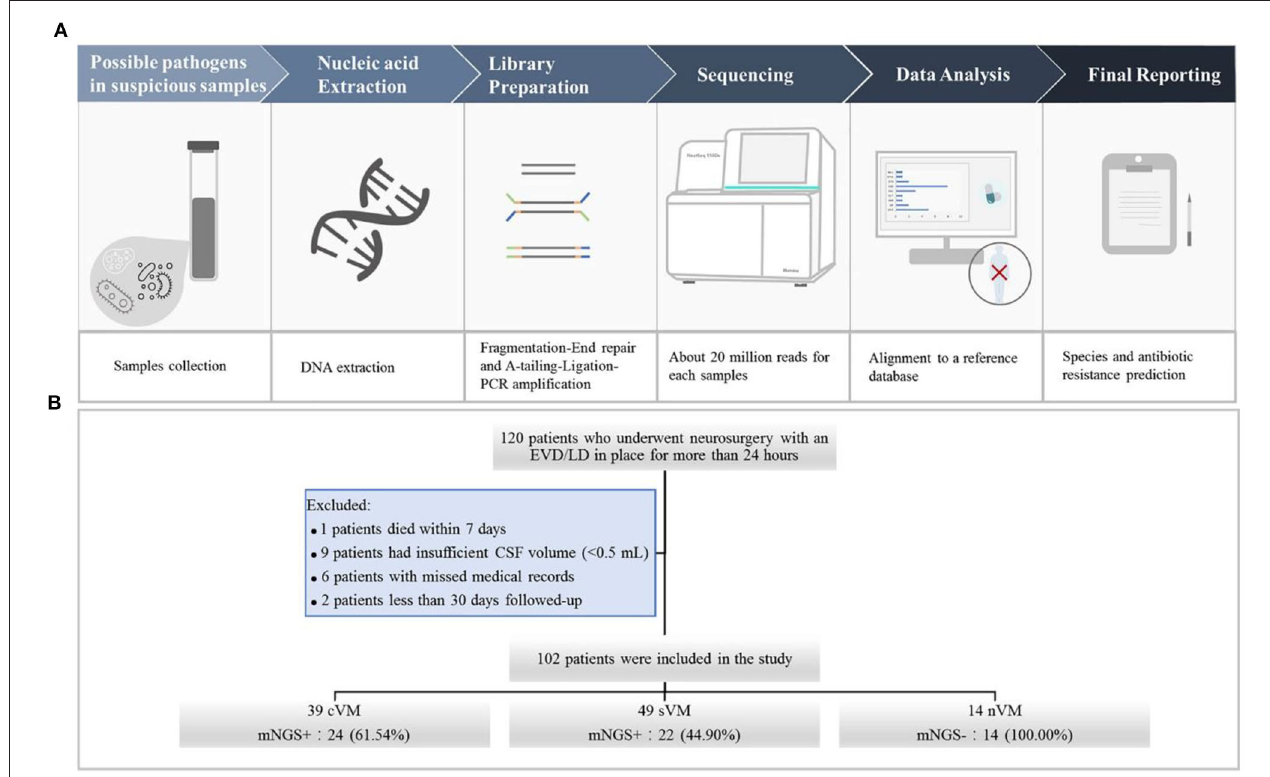
FIGURE 1 | (A) Schematic of the mNGS workflow. After collecting CSF samples, DNA was extracted using the TIANamp Magnetic DNA Kit (Tiangen). DNA libraries were prepared using the KAPA Hyper Prep kit (KAPA Biosystems) and fragmentation-end repair and a-tail-ligation PCR amplification. Libraries were quantified, pooled, and loaded onto the sequencer. Using an in-house-developed bioinformatics pipeline, high-quality sequencing data were obtained. Reads were aligned to the NCBI microorganism genome database for pathogen identification. Finally, we reported the results of mNGS according to the criteria. (B) Flowchart of study